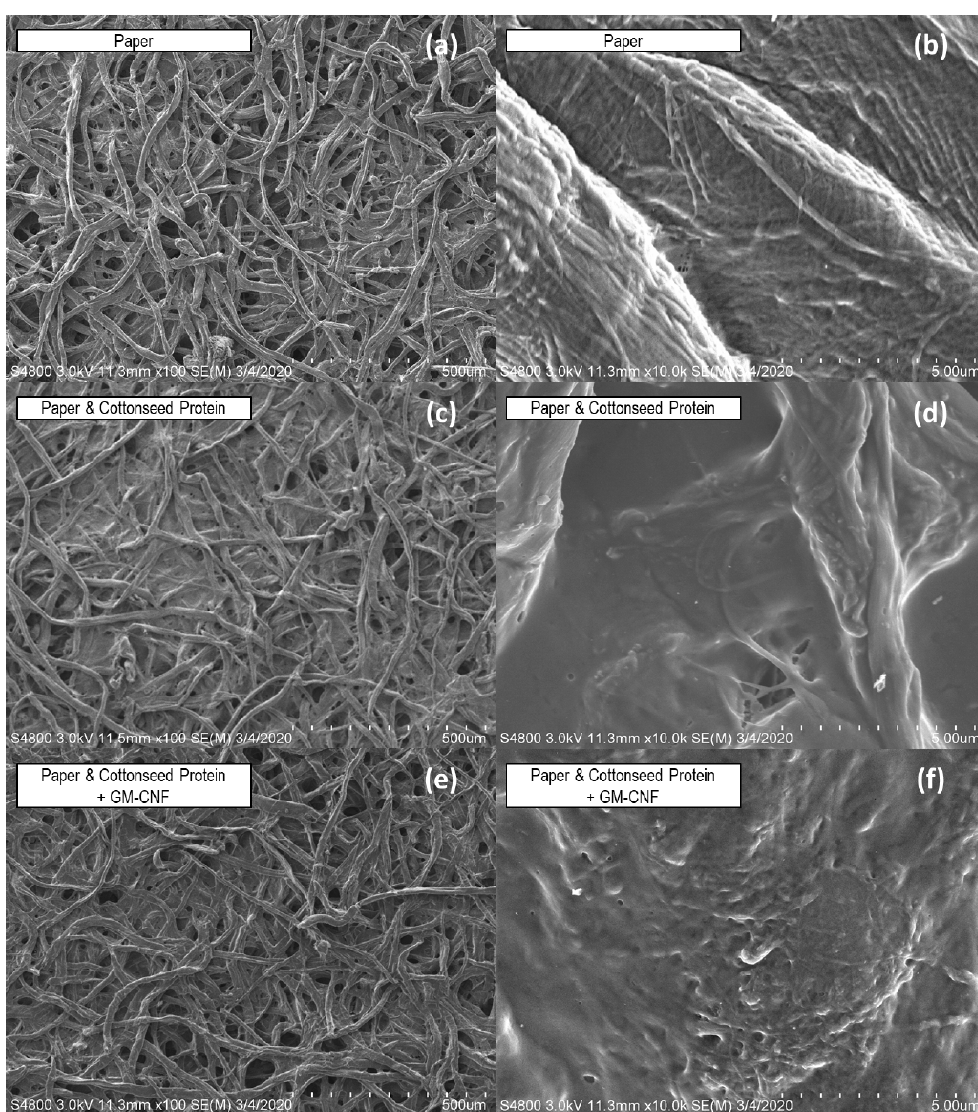
Figure 4. FESEM micrographs at 100× ( a , c , e ) and 1000× ( b , d , f ) of paper ( a , b ) and paper treated with 10 wt% CSP solution ( c , d ) and 0.2 wt% GM-CNF and 10 wt% CSP ( e , f ).